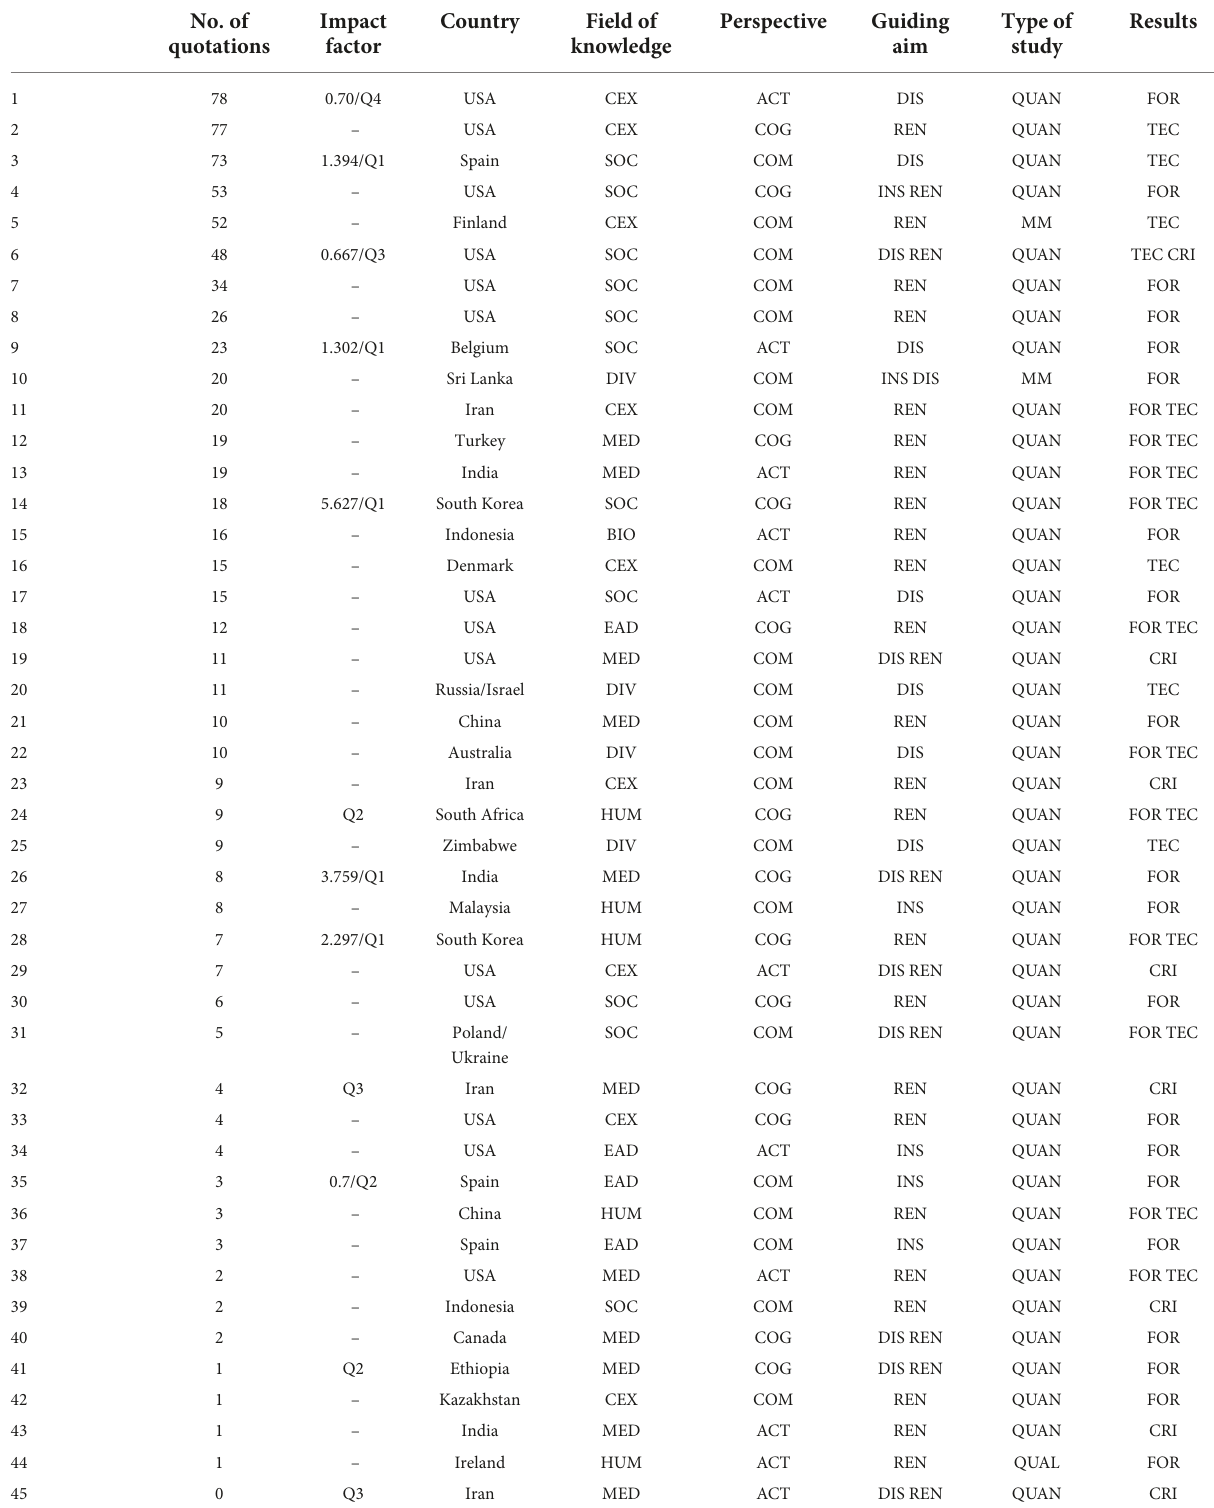
TABLE 3 Analytical framework of the sample of reviewed empirical